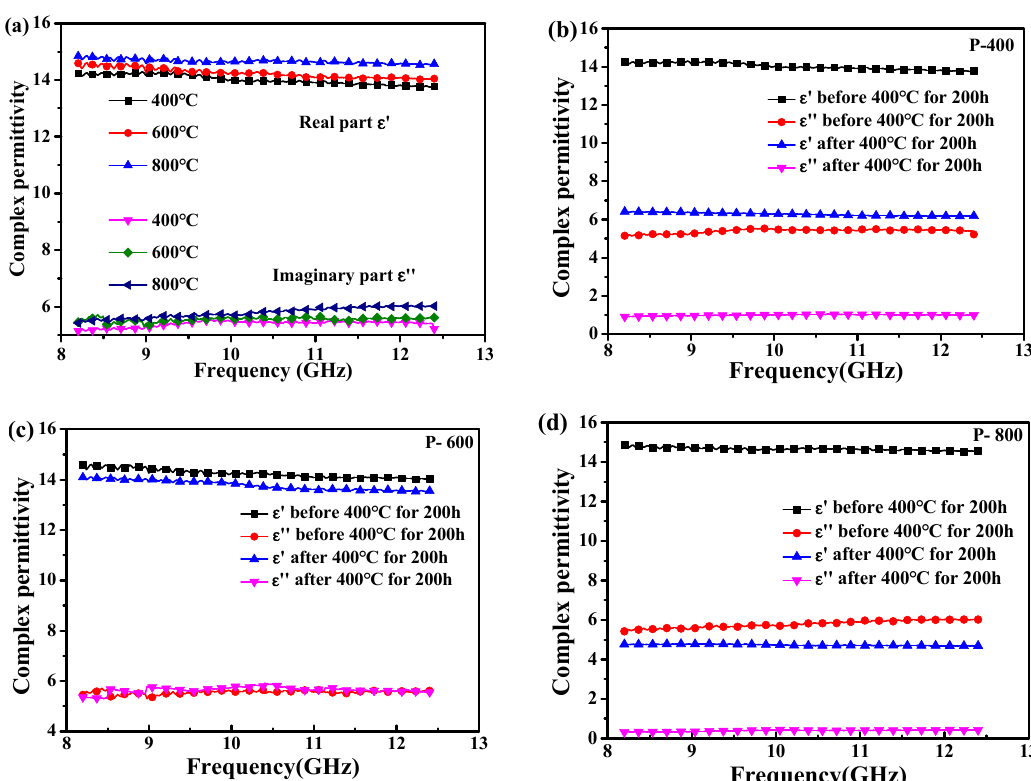
Figure 5. Complex permittivity of ( a ) the PCS-coated CNTs powder pyrolyzed at 400–800 °C before heat treatment and ( b – d ) different SiC/CNTs composites after heat treatment at 400 °C in air for 200 h.